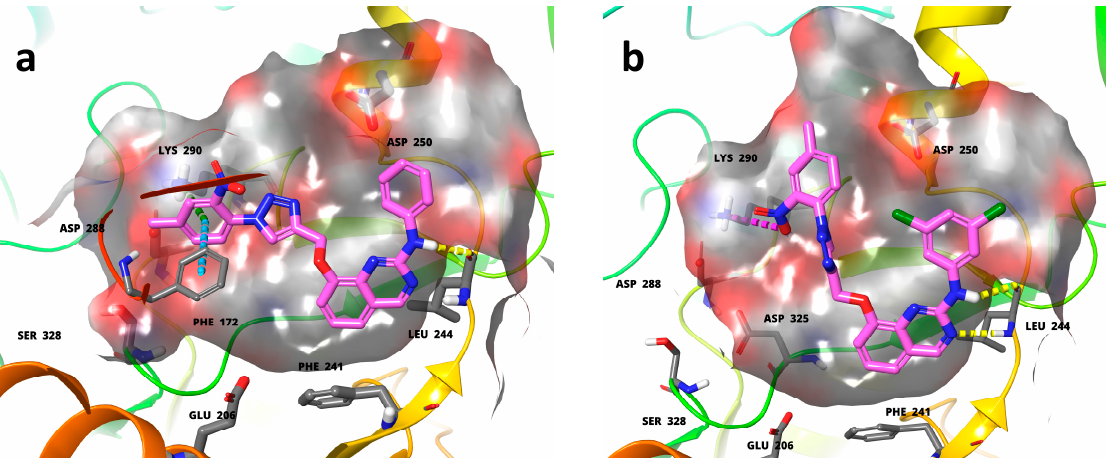
Figure 2. ( a ) 7a in CLK1 cavity; ( b ) 7b in CLK1 cavity; the ligands 7a and 7b are shown as thick residues in color-faded magenta. Color coding: oxygen-red, nitrogen-blue, carbon-grey (in case of protein). Backbone, side chain hydrogen bonds are shown as yellow dotted lines, π - π stackings are given in light blue dotted lines and and π -cation showed in green dotted lines whereas, charged interactions are provided in pink dotted lines. To focus the interactions of active site residues with ligands 6.0, Å surface area of protein has been shown in the figures.